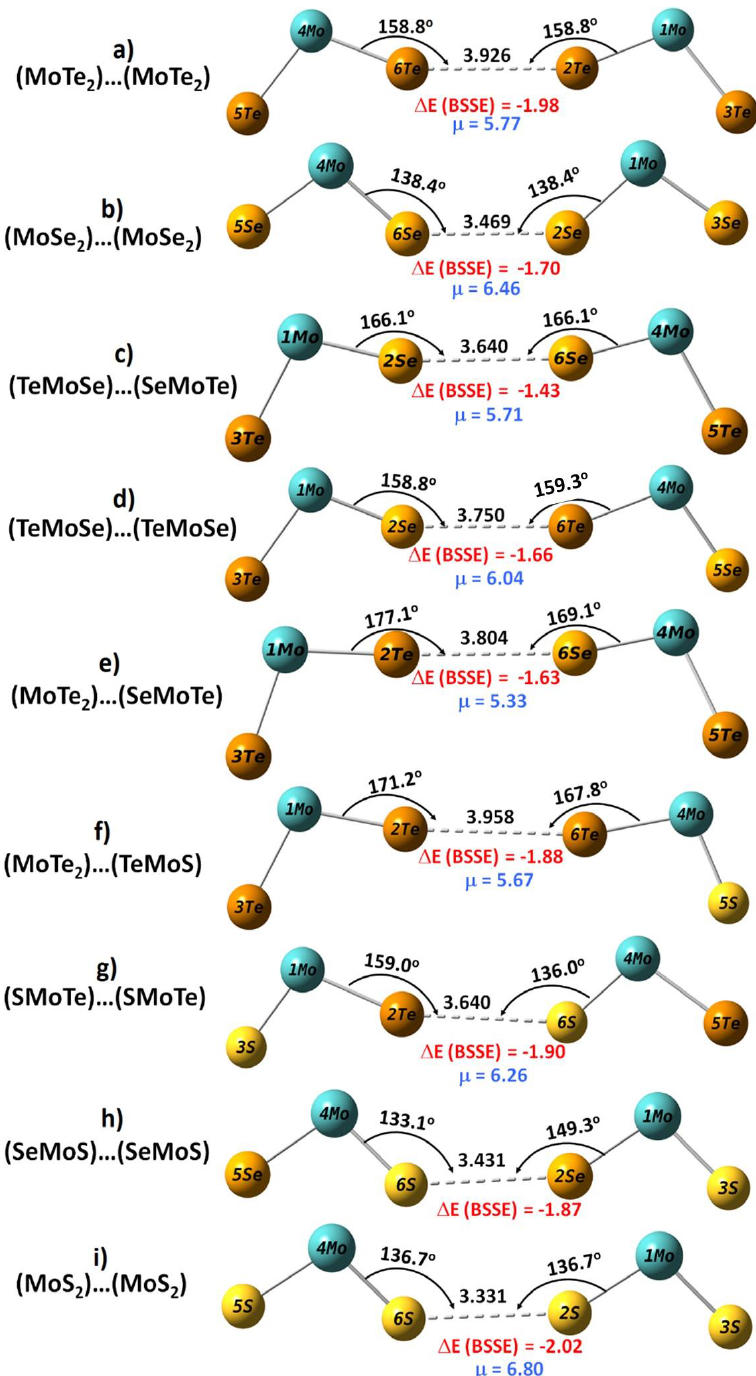
Figure 3. MP2(Full)/def2-TZVPPD computed energy-minimized geometries of (MoCh 2 ) 2 (Ch = Se, Te) and (MoChCh (cid:48) ) 2 (Ch, Ch (cid:48) = S, Se, Te) dimers. Intermolecular bond distances, r (Ch ··· Ch), and bond angles, ∠ Mo–Ch ··· Ch, are in Å and degrees, respectively. The basis set superposition error corrected binding energies ( ∆ E(BSSE)/kcal mol − 1 ) and overall dipole moments ( µ /D) of the dimers are shown. Table S2 of the Supplementary Materials lists the relaxed redundant internal coordinates of all the nine dimers.